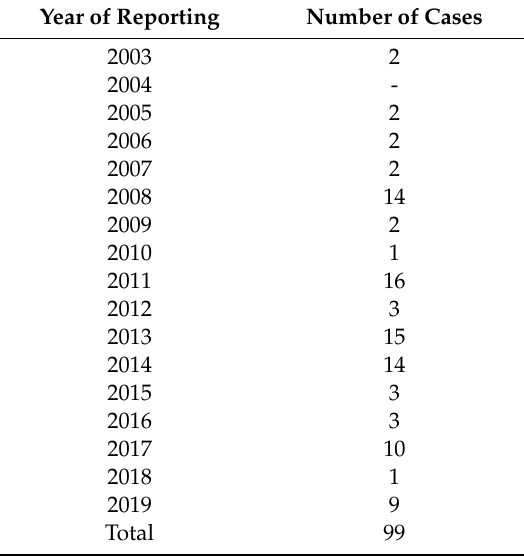
Table 3. Number of reported measles cases by year of reporting (n=97)